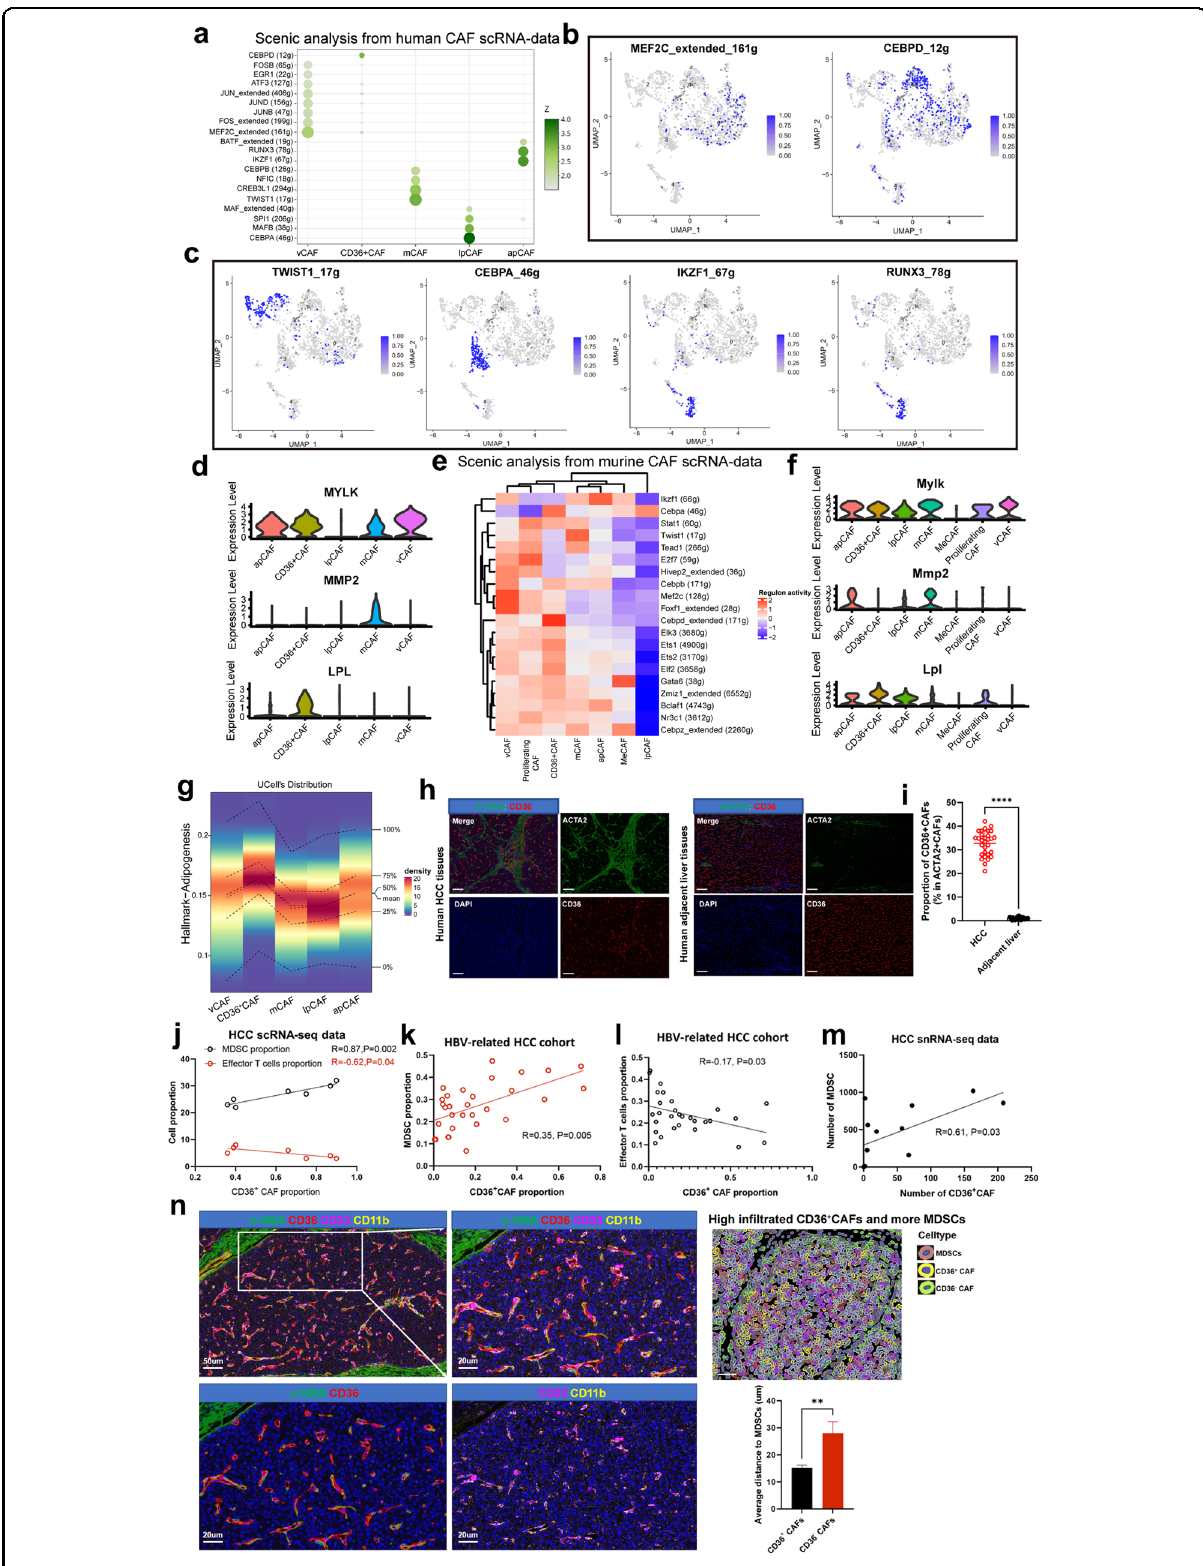
Fig. 3 (See legend on next